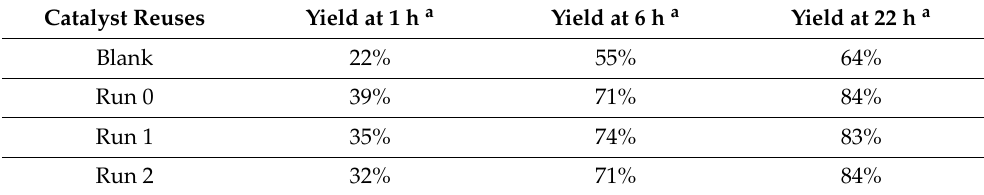
Table 2. Screening at a catalyst loading of 1%, in moles, with respect to glycerol. Catalyst Reuses Yield at 1 h a Yield at 6 h a